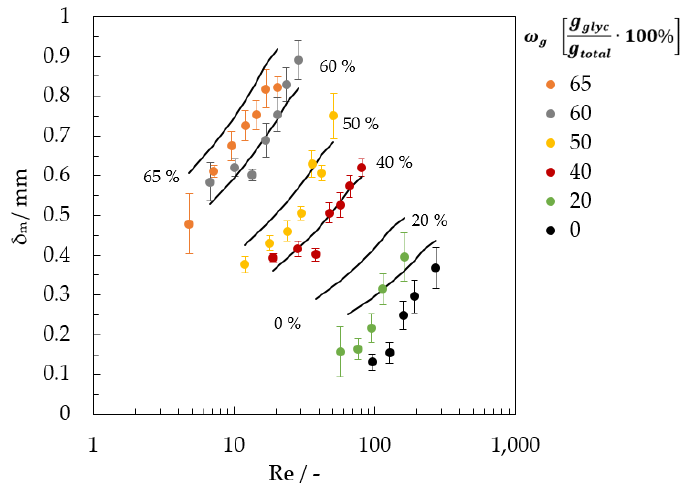
Figure 13. Results of film thickness measurement using VIS image analysis for the falling film with